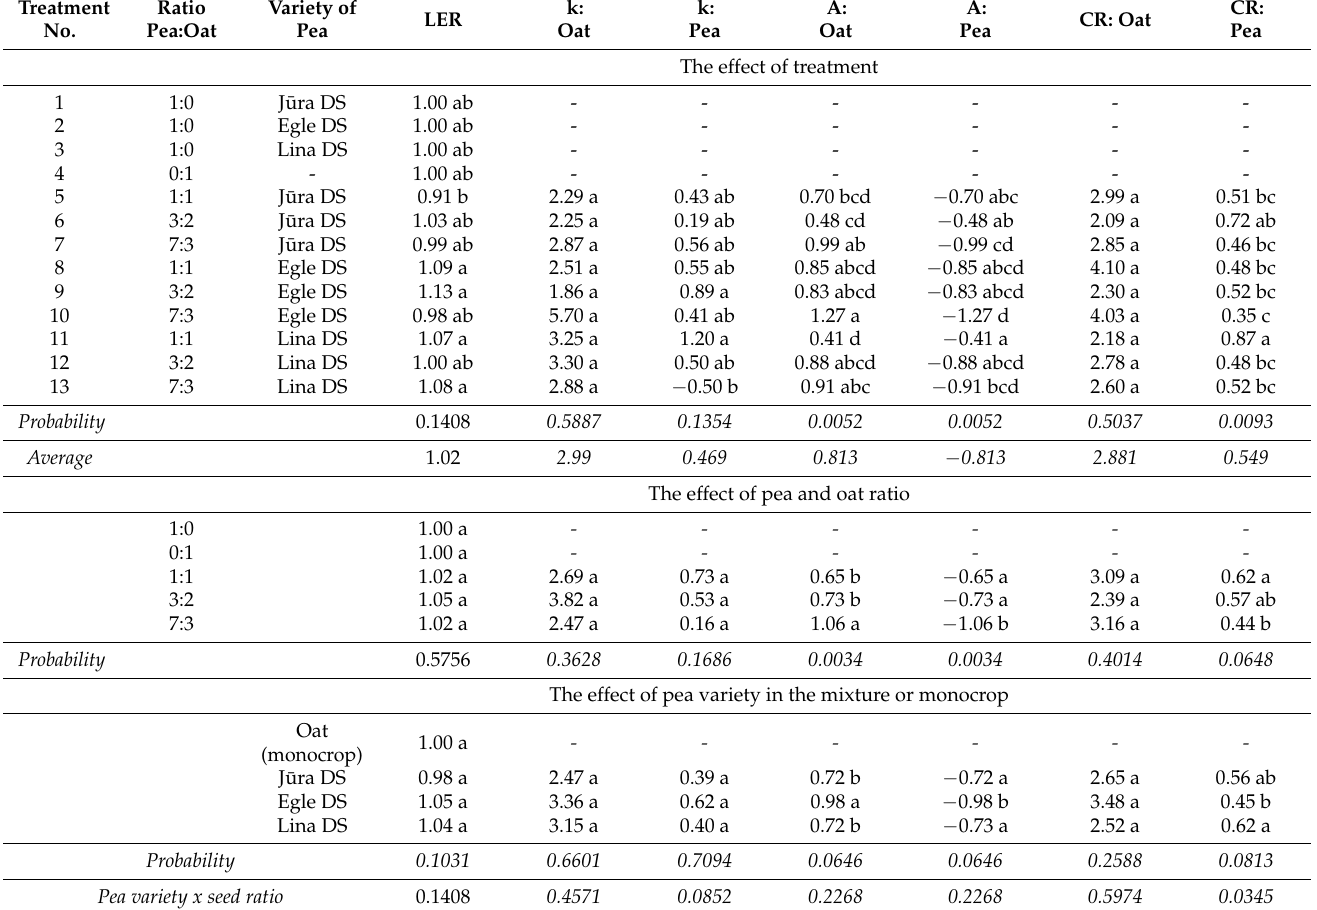
Table 5. Land equivalent ratio for grain (LER), relative crowding coefficient of Crop a intercropped with Crop b (k), aggressivity (A) and competitive ratio (CR) of oat–pea mixed crops as affected by the ratio (%), averaged over the three